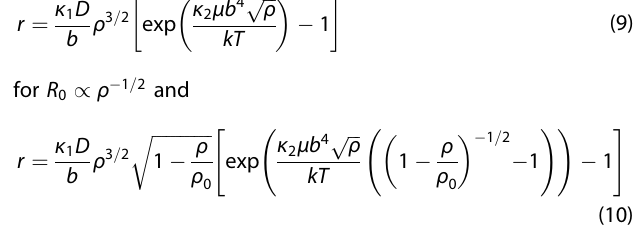
Fig. 7 Expressions for residual hardening fi tted to the inter- mediate density DDD simulations. For the power-law climb expression, Eq. (6), both powers of ½ (for bulk diffusion) and ¼ (for pipe diffusion) are